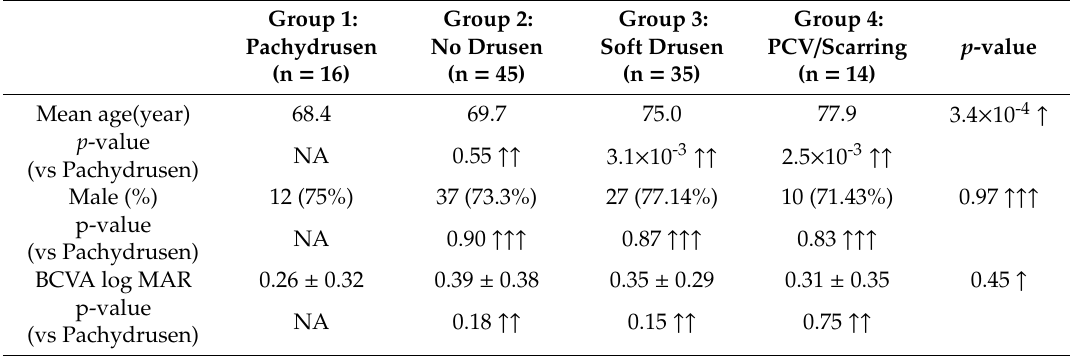
Baseline demographic and clinical characteristics of patients with polypoidal choroidal